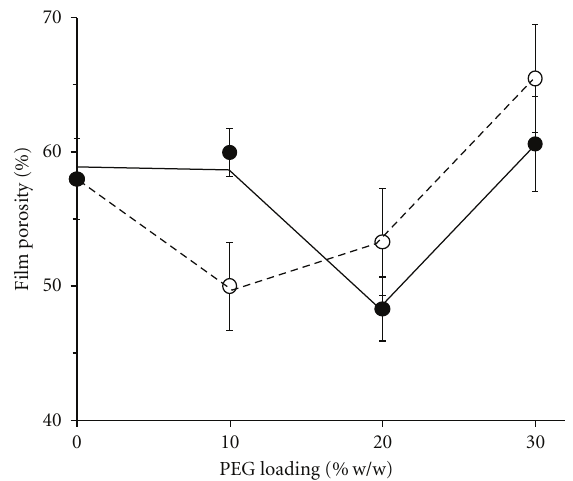
Figure 7: Change in porosity of PHB/PEG composite films with increasing PEG loading (% w/w), ( ◦ ) PEG106 and ( • ) PEG2000.